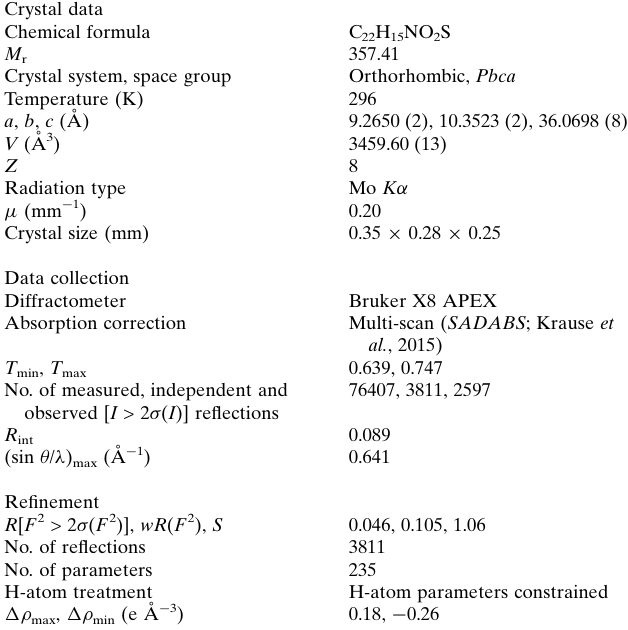
Crystal data Chemical formula